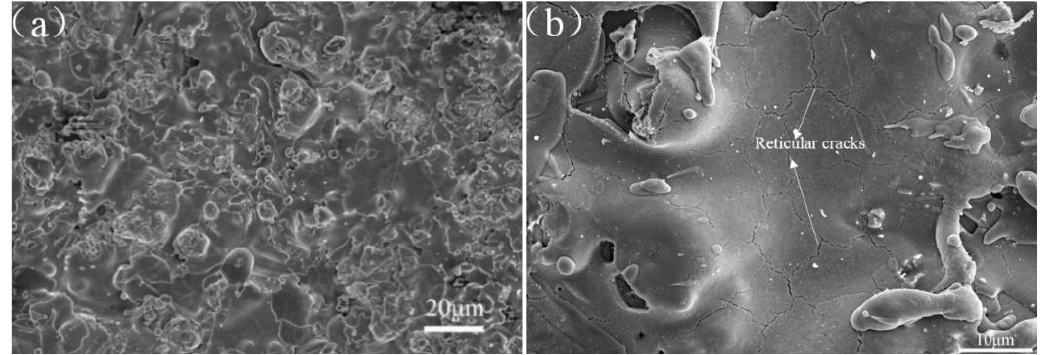
Figure 3. SEM images of TiO 2 -15MgAl 2 O 4 coating surface. (a) low magnification ; (b) high Figure3. SEMimagesofTiO 2 -15MgAl 2 O 4 coatingsurface. ( a )lowmagnification; ( b )highmagnification. magnification Figure 2. XRD patterns of TiO 2 -15MgAl 2 O 4 powder and coating.